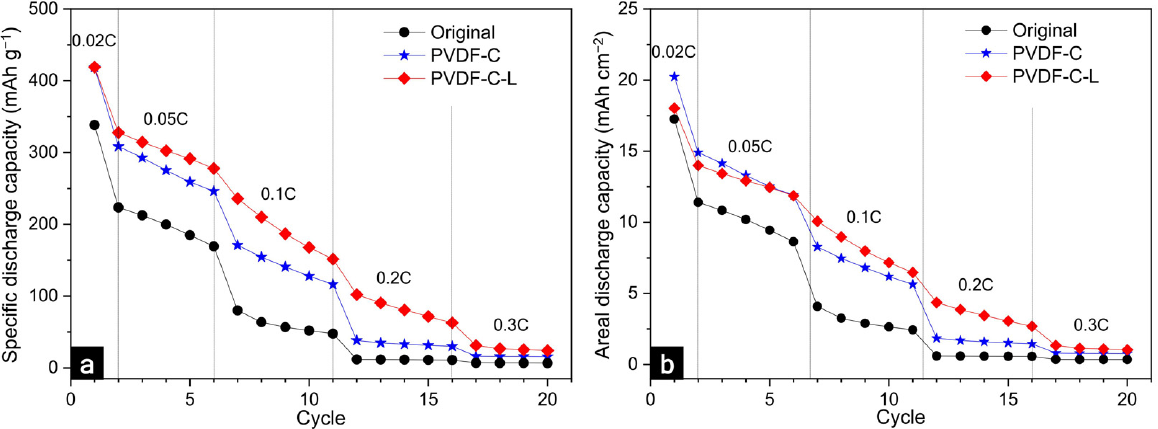
Figure 7. Comparison of the performances, such as ( a ) the discharge capacity normalized by the mass of the active material and ( b ) the areal discharge capacity.